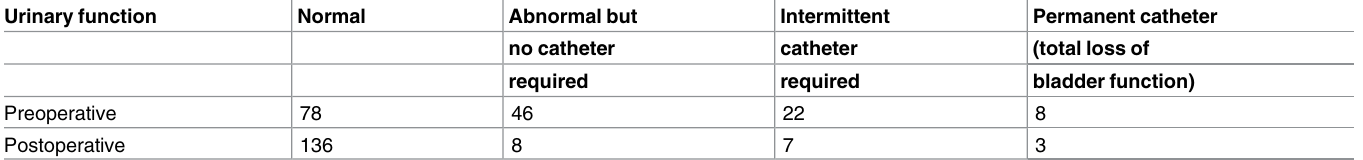
Table 6. Comparison of Pre- and Postoperative Urinary Sphincter Muscle